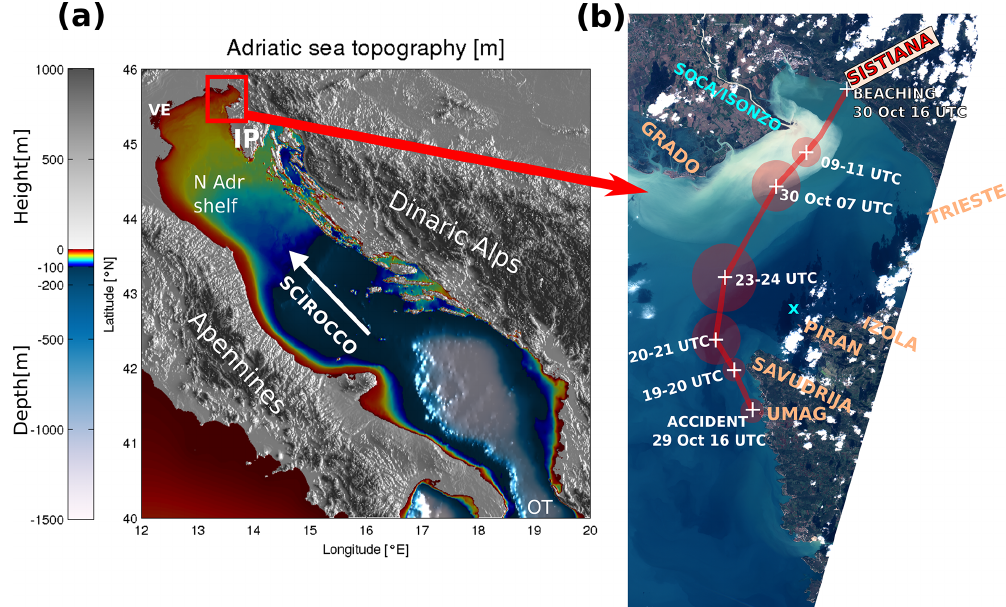
Figure 1. (a) Adriatic basin bathymetry. Abbreviations are as follows: VE – Venice; IP – Istrian Peninsula; N Adr Shelf – northern Adriatic Shelf; OT – Otranto Strait. The direction of the scirocco is marked with a white arrow. (b) The Gulf of Trieste and piecewise trajectory of the drift as estimated by the survivor. Location estimates are junctions of the piecewise straight line. Circles denote location uncertainty estimates at specific times. The cyan “X” sign north of Piran denotes the location of the Vida coastal buoy. The background layer is a Sentinel-2 L1C true colour image of the Gulf of Trieste from the day after the beaching, 31 October 2018 (obtained from Copernicus Open Access Hub: https://scihub.copernicus.eu, last access: 19 August 2020). The turbid Soˇca River plume is clearly visible along the northern shore of the Gulf.